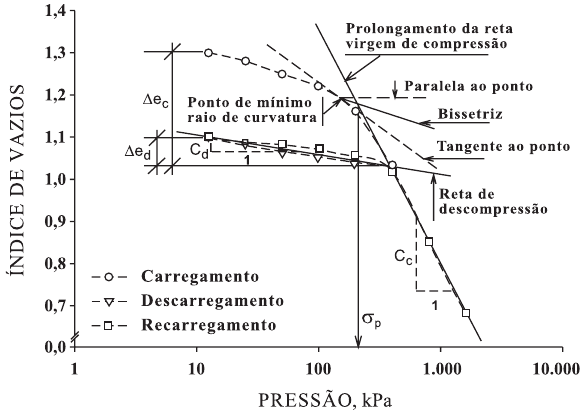
Figura 1. Curva de compressão com indicações da reta virgem, da reta de descompressão e do cál- culo do índice de recuperação (Ir). ΔΔΔΔΔ e ção do índice de vazios durante o carregamento; ΔΔΔΔΔ e = variação do índice de vazios durante o des- d carregamento; c = coeficiente de descompressão; d c = coeficiente de compressibilidade; σσσσσ c são de